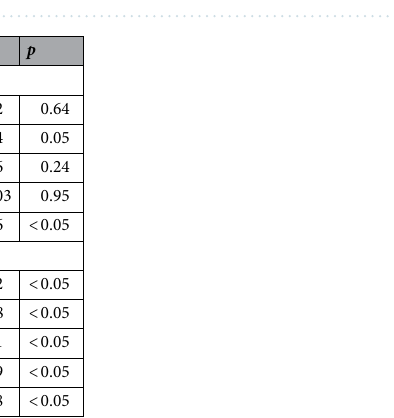
Figure 6. Temporal changes in the density of adult and juvenile D. antillarum on small artificial reef structures and nearby control reefs. Data were collected at the same time each year, but points are jittered to aid visualisation. Data shown are mean ± SE.